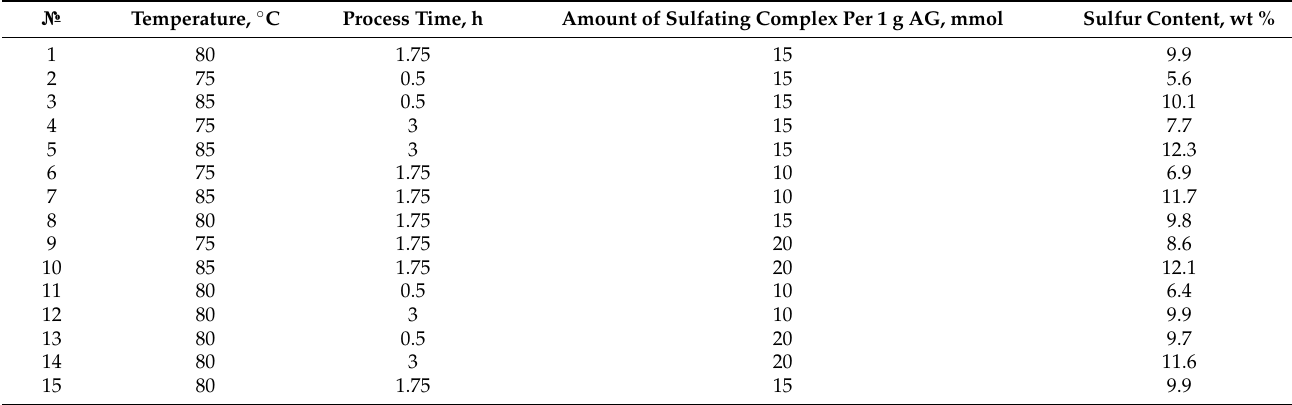
Table 3. Effect of the conditions for arabinogalactan sulfation with sulfamic acid in 1,4-dioxane in the presence of urea on the degree of substitution in arabinogalactan